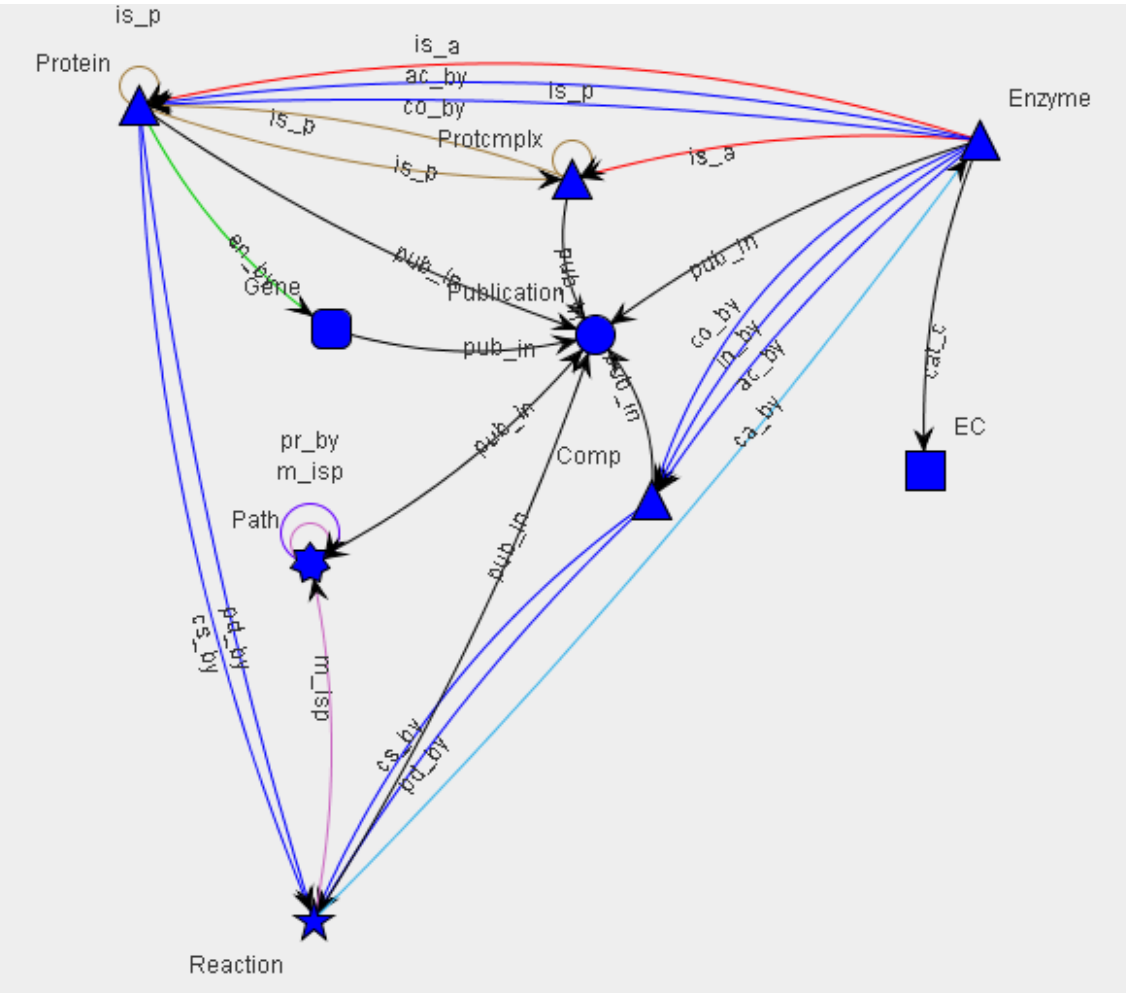
Figure 2: ONDEX MetaGraph for the AraCyc